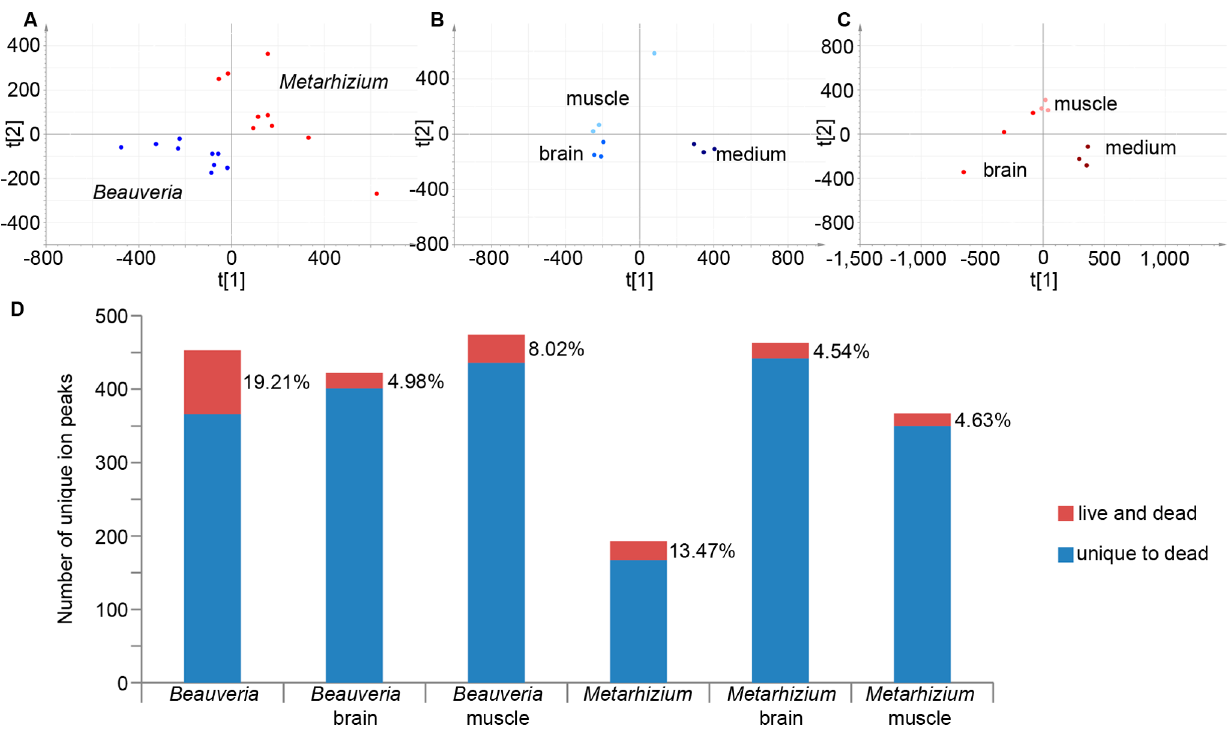
Figure 3. Overview of data obtained from analyses done to determine secretome heterogeneity on dead ant tissues. A-C depict the supervised PCA plots for A) general Beauveria and Metarhizium growth on dead tissues, B) different types of Beauveria growth, and C) different types of Metarhizium growth. D) Bar graph representing the number of unique ion peaks found in the comparisons of the two fungal species with each other and the comparison of dead tissue growth related ion peaks within those species. The top part of the bars represents the percentage of metabolites in common with fungal growth on live tissues.